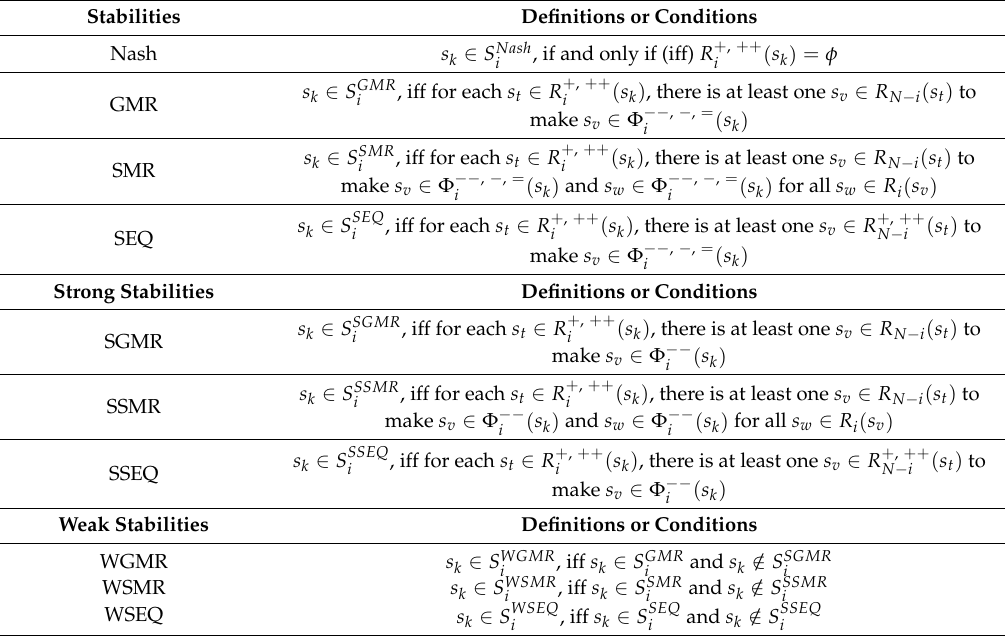
Table 2. Stability definitions in terms of strength of